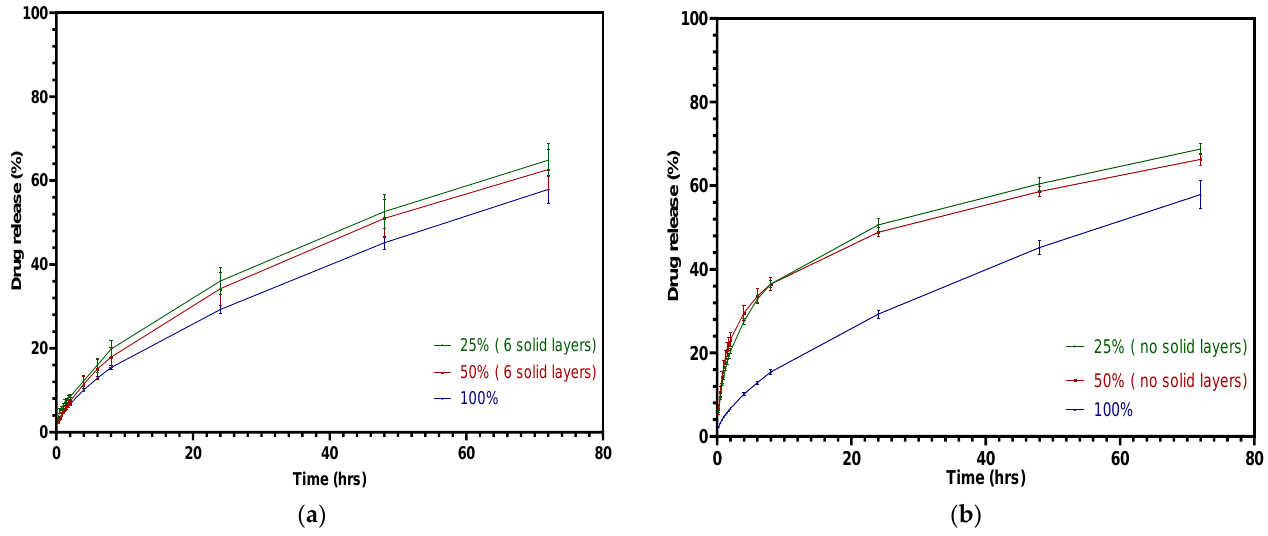
Figure 14. Cumulative theophylline release over 72 h in HCl-KCl pH 1.2 media for tablets: ( a ) over- printed, 6 solid layers; ( b ) overprinted, no solid layers.